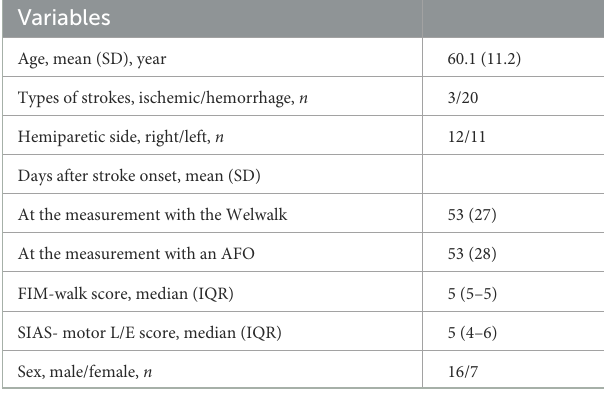
TABLE 1 Definitions of index values representing the severity of abnormal gait.